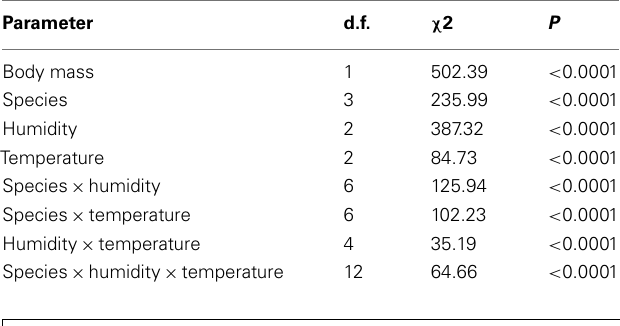
Table 2 | Summary of generalized linear model results [degrees of freedom (d.f.), chi-square ( χ 2 ) statistic and corresponding P -value ( P )] (normal distribution of errors and identity link function) for time to death (in h) as dependent variable, initial body mass (in mg) as a continuous predictor and relative humidity (in %), temperature (in ˚C), and species main and interaction effects (indicated with × ) as model parameters.